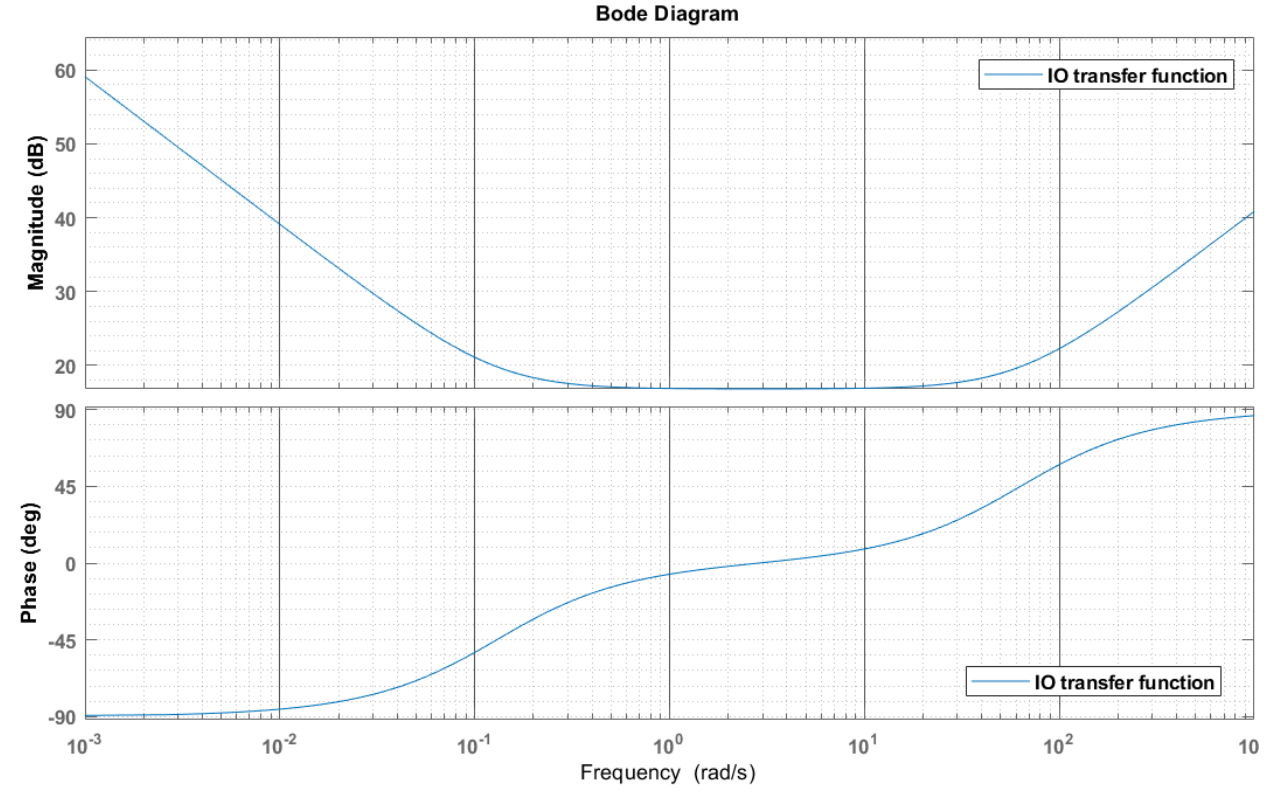
Figure 3. Bode plot for IO transfer function of controller for Link 1.